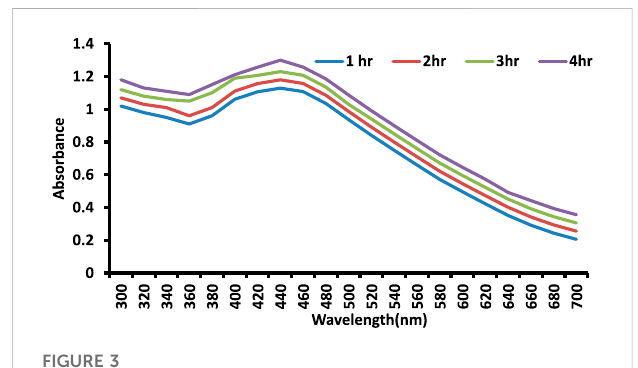
FIGURE 3 Time kinetics study of as-prepared